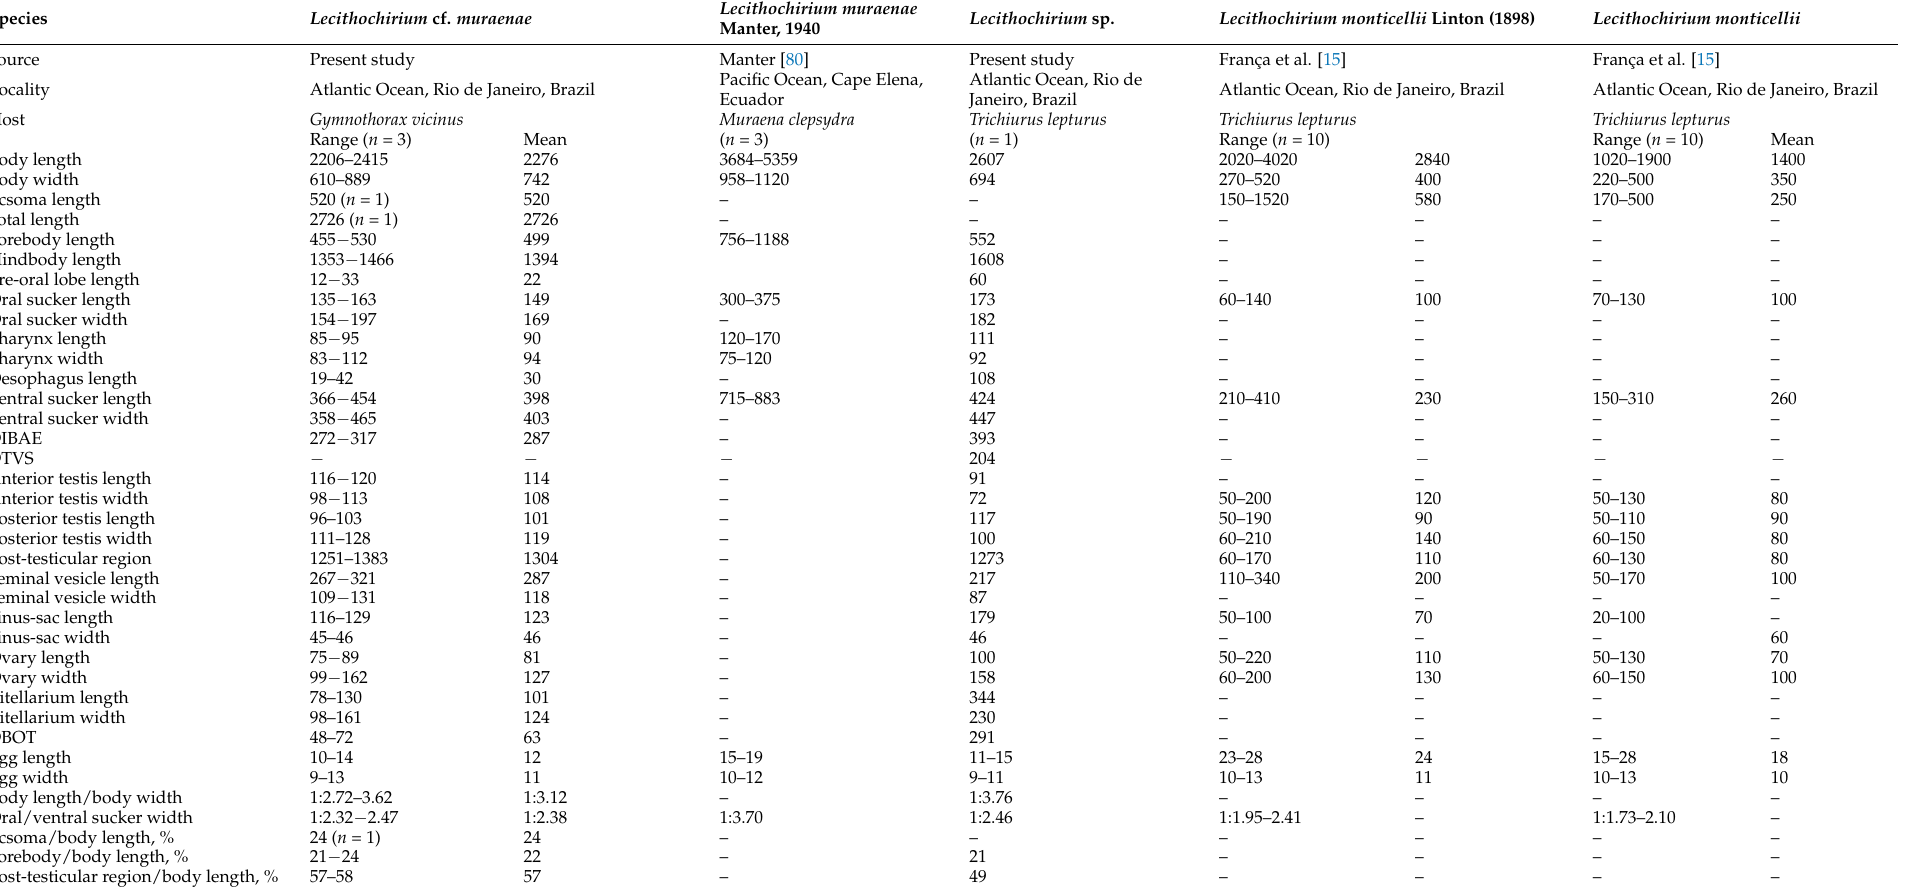
Table 5. Comparative metrical data of Lecithochirium